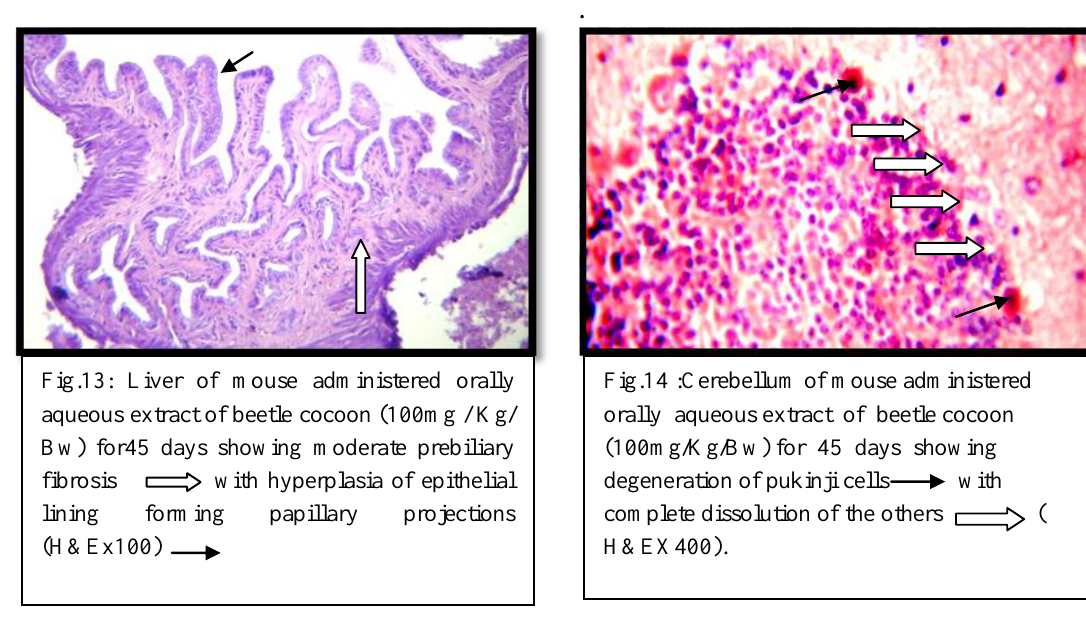
Fig. 11: Lung of mouse administered orally aqueous extract of beetle cocoon (50mg /Kg/Bw)for 45 days showing thickening of interalveolar septa , congestion and mononuclear cells infiltration (H&Ex400)